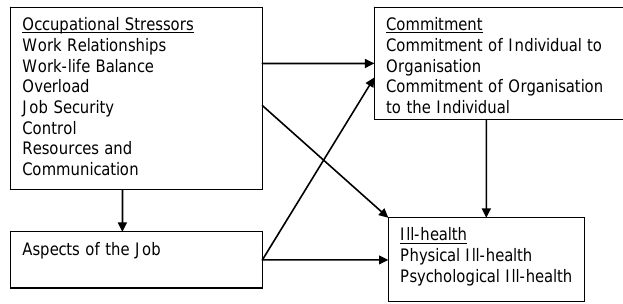
Figure 1: Model of occupational stress, commitment and ill